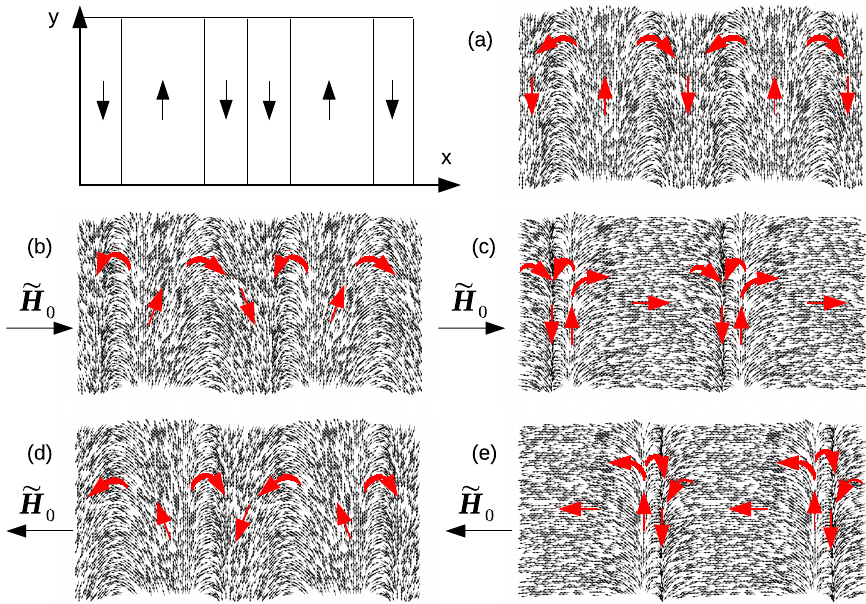
Figure 3. Distribution of the magnetization vector m in the magnetic field applied along the x axis: